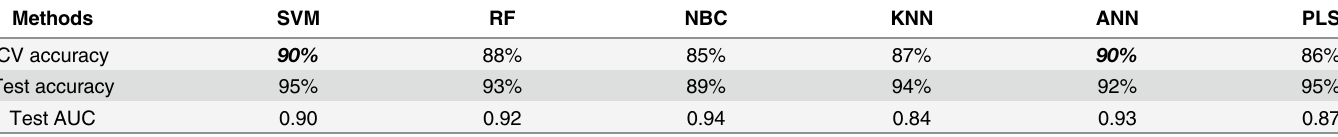
Table 3. ddG binary classification.